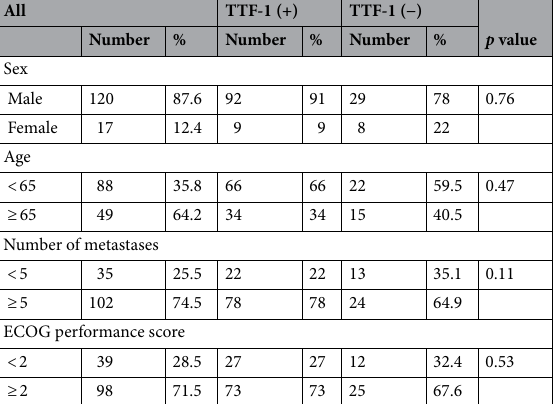
Table 1. Demographic and clinical characteristics of all patients. TTF-1, thyroid transcription factor 1; ECOG, Eastern Cooperative Oncology